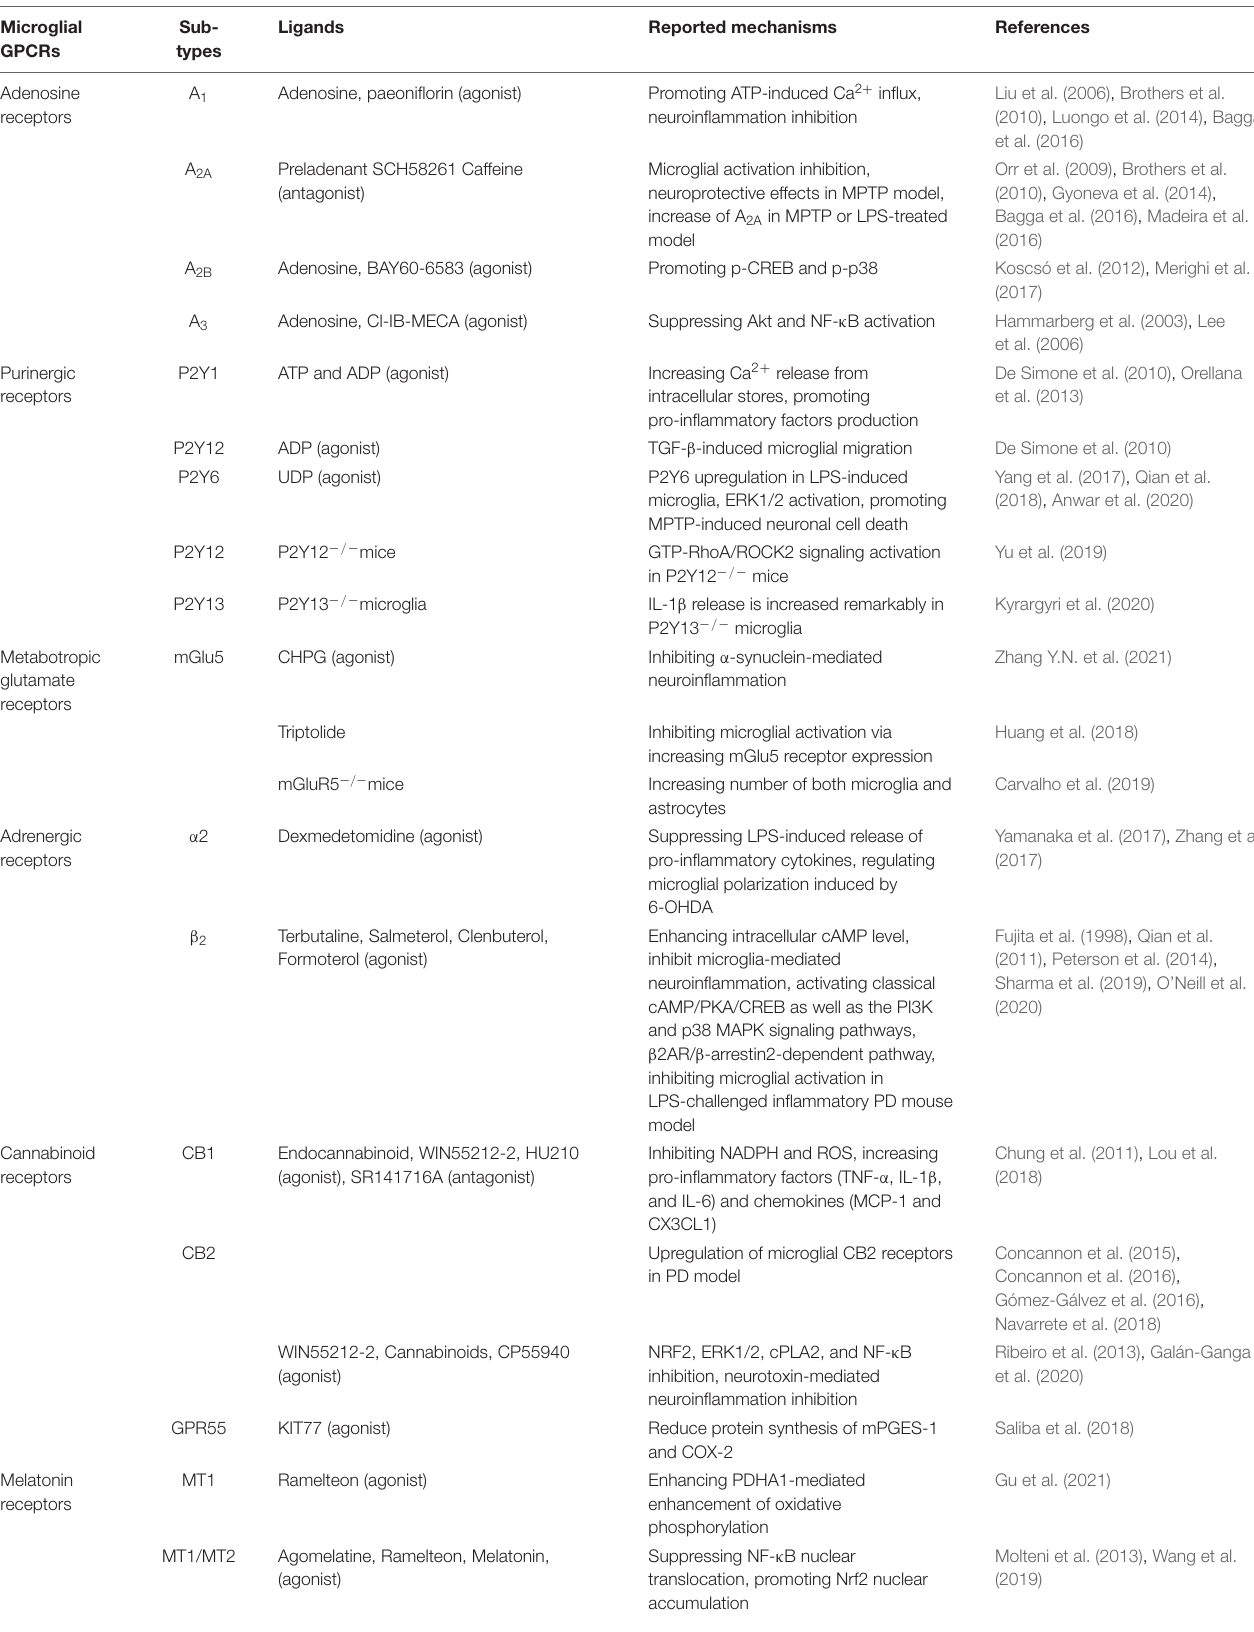
TABLE 1 | Reported microglial GPCRs and their potential roles in